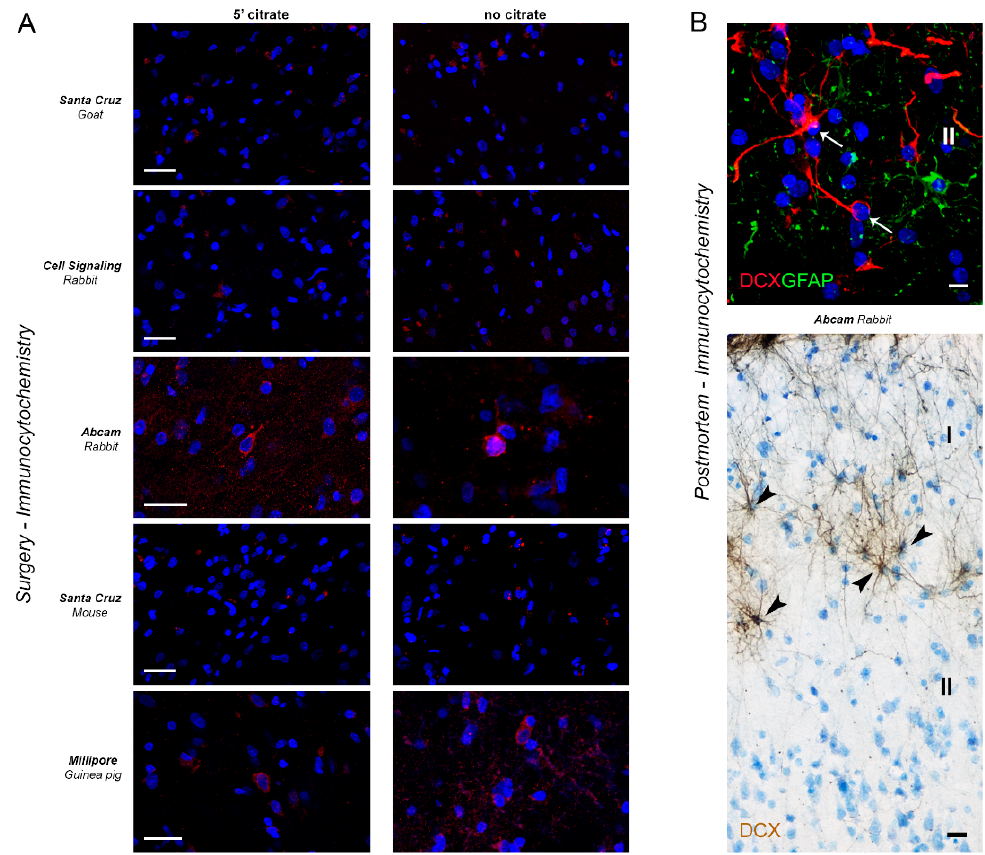
Figure 8. Detection of DCX in the human neocortex by immunocytochemistry. ( A ) Immunocytochemical staining for DCX (red) by using different antibodies, both with and without citrate buffer treatment. Confocal images taken in cortical layer II-III (I, II, cortical layers). ( B ) Immunocytchemistry on post-mortem brain tissue with Abcam primary antibody reveals some unipolar/bipolar neurons (arrows) in layer II, but also a non-specific staining on interlaminar astrocytes in layer I (arrowheads; see Figure 9). Scale bars: 20 µm.